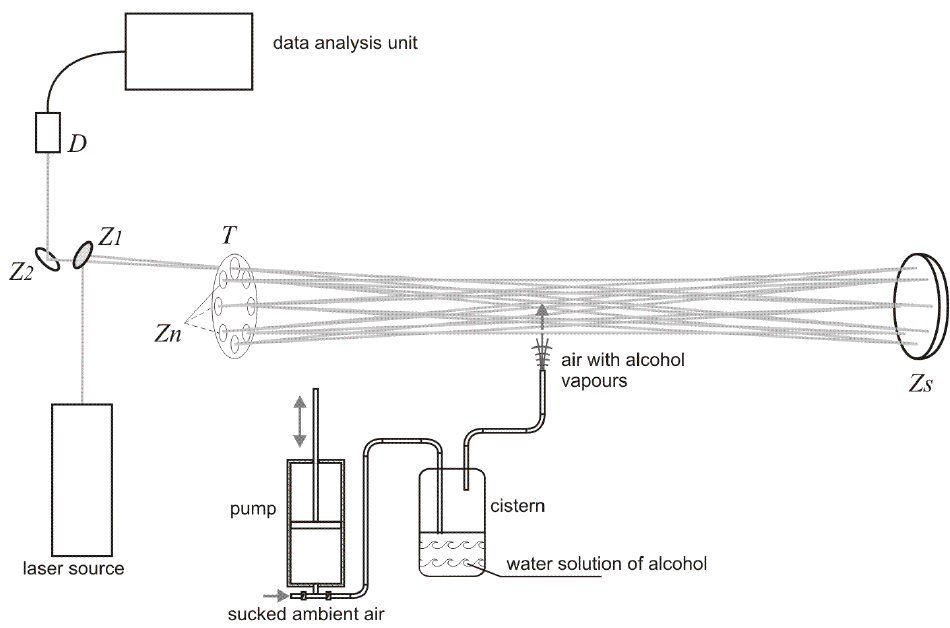
Figure 2. Experimental setup used for investigation of alcohol detection in the air exhaled by humans.